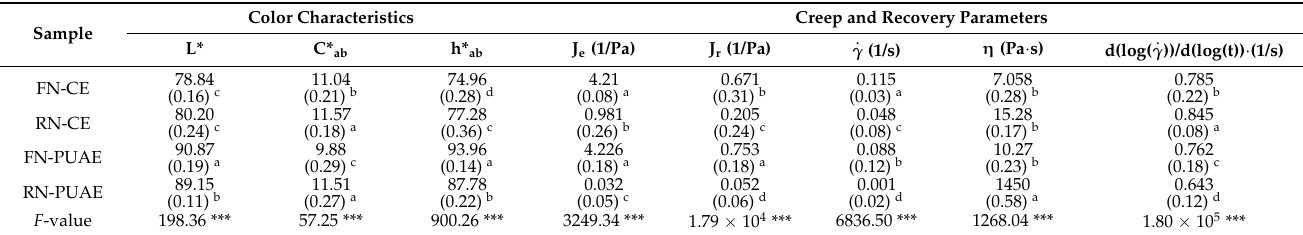
Table 2. Color characteristics, creep and recovery parameters of pectin samples. Mean values and standard deviation, in brackets.